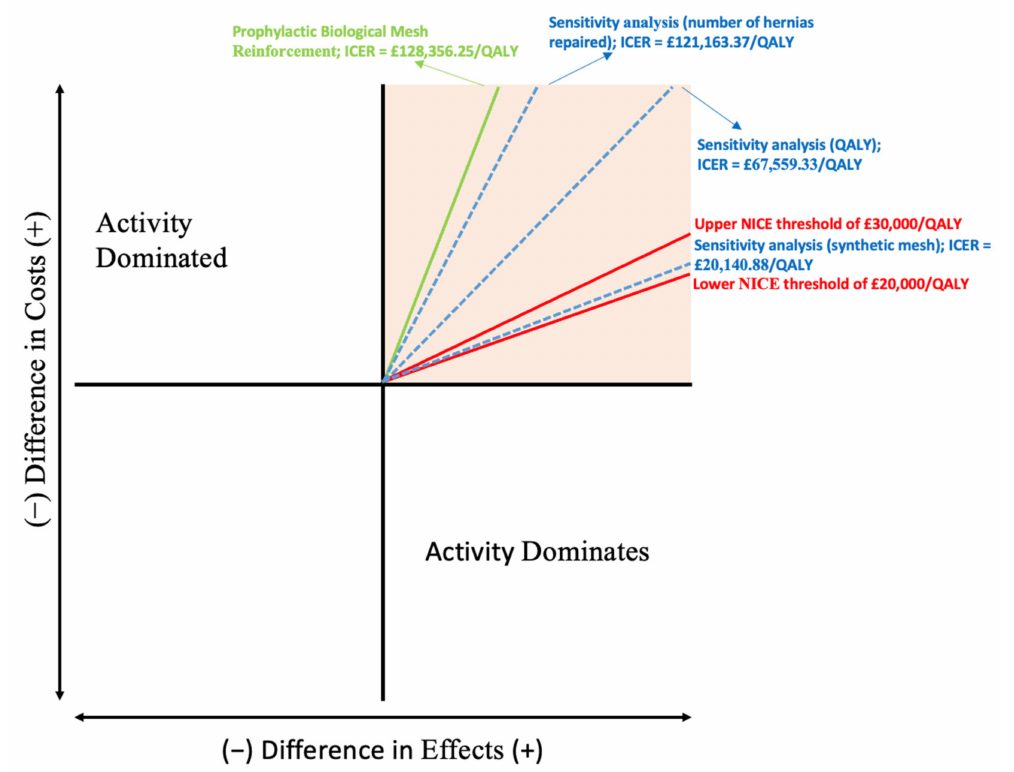
Figure 2. Cost-effectiveness plane for the ICER calculated between mesh prophylaxis and standard suture closure, including results from univariate sensitivity